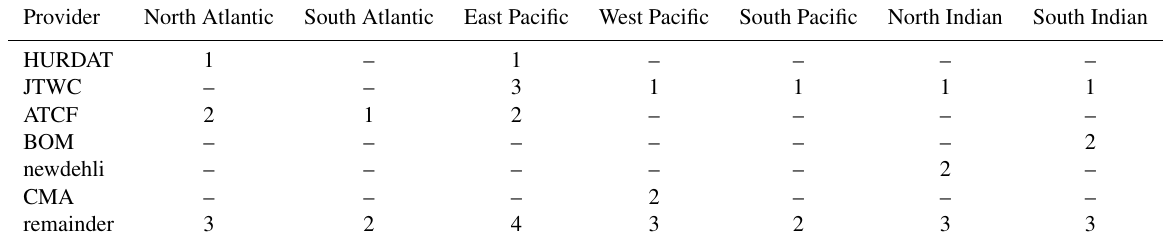
Table 1. List of consulted data providers within the IBTrACS archive broken down by ocean basin. Numbers indicate order of priority. The row “remainder” has lowest priority for all basins and data from this source are only used in very few cases to provide estimates for otherwise missing data. Abbreviations are the following: HURDAT, Hurricane Databases of the National Hurricane Center; JTWC, Joint Typhoon Warning Center (available for various basins); ATCF, Automated Tropical Cyclone Forecast; BOM, Bureau of Meteorology (Australia); newdehli, Regional Specialized Meteorological Center New Dehli, India; CMA, China Meteorological Administration – Shanghai Typhoon Institute; remainder, [VARIABLE_NAME]_for_mapping variables in IBTrACS